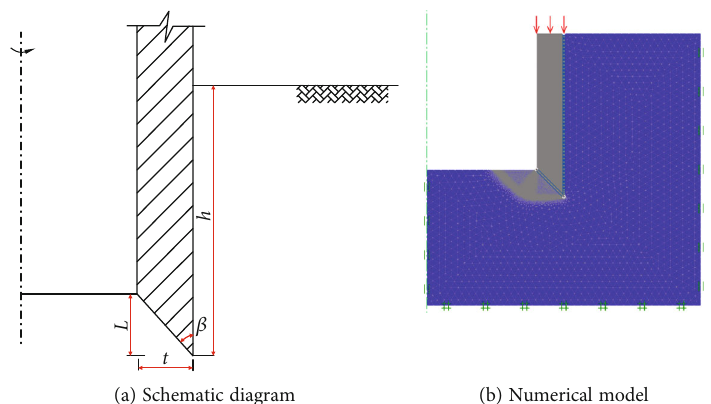
Figure 13: Analytical model of the ring foundation with the cutting